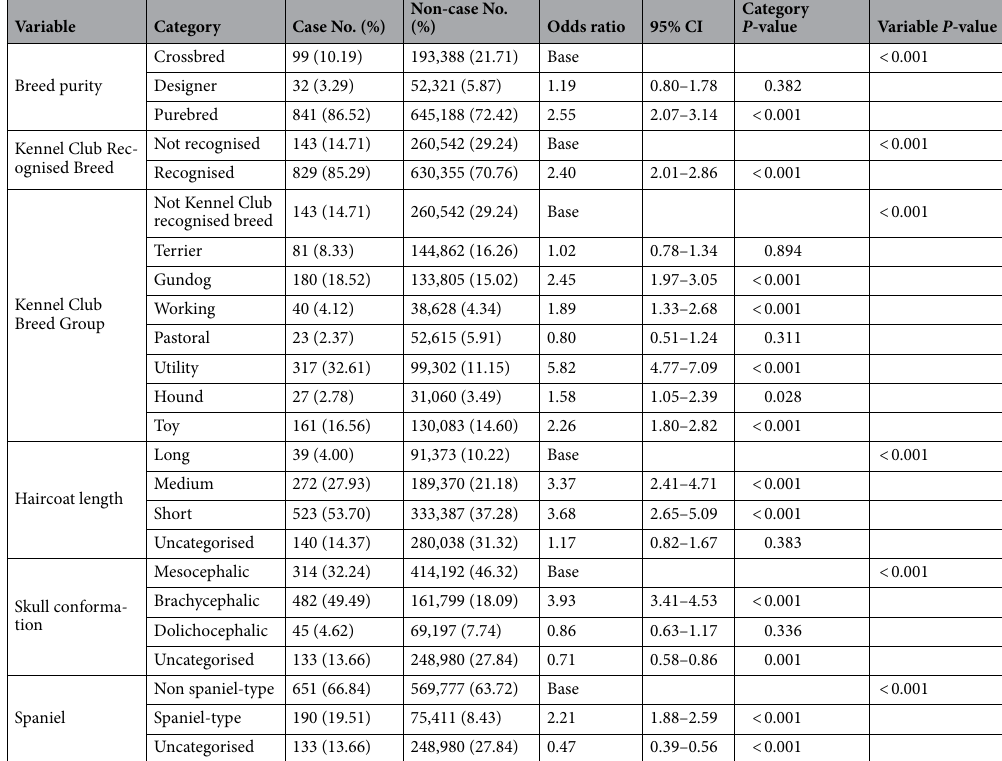
Table 3. Descriptive and univariable logistic regression results for breed-derived risk factors for skin fold dermatitis during 2016 in dogs under primary veterinary care in the VetCompass Programme in the UK. Column percentages shown in brackets. CI confidence